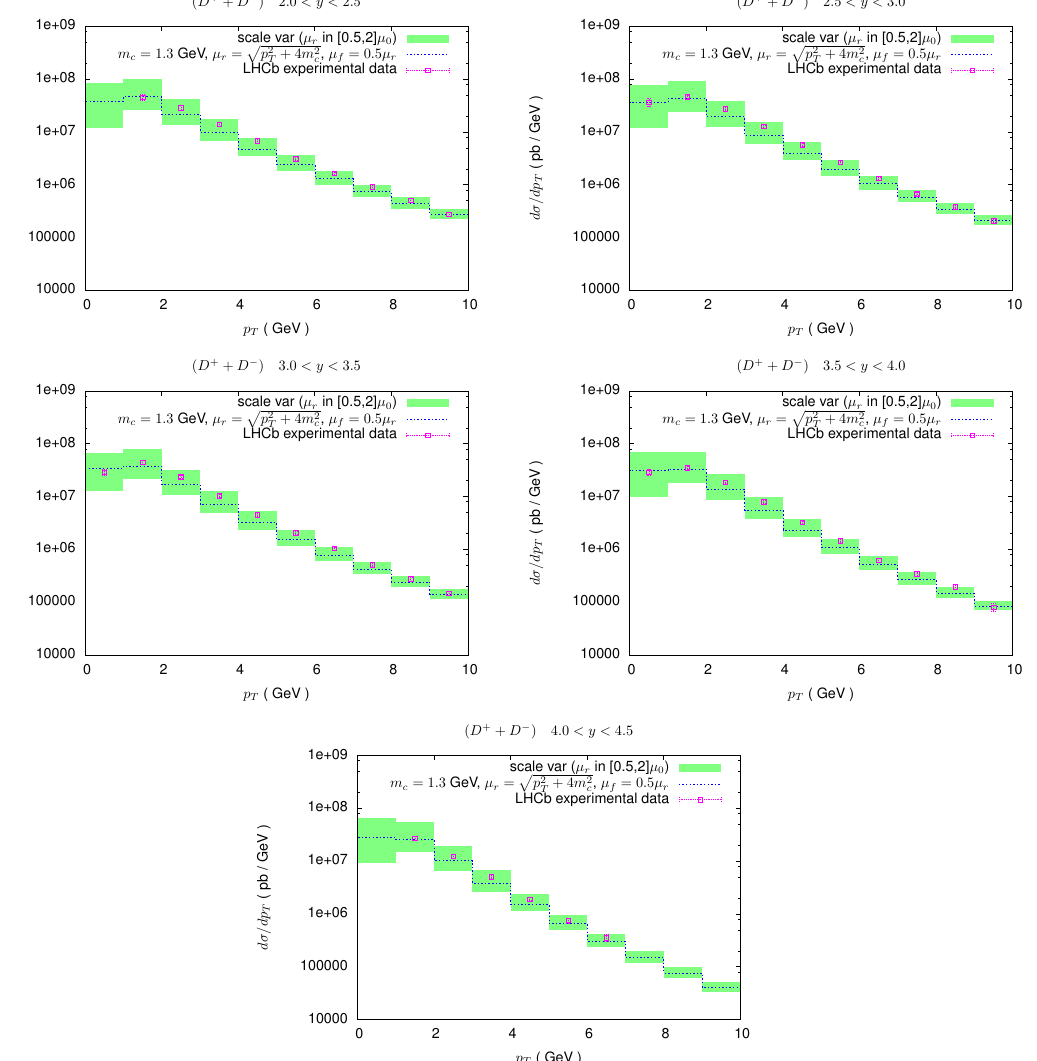
Figure 2 . Our GM-VFNS predictions for ( D + + D (cid:0) ) transverse-momentum distributions for pp collisions at p S = 5 TeV vs. LHCb experimental data of ref. [43]. Each panel corresponds to a di(cid:11)erent rapidity bin in the interval 2 < y < 4.5. The renormalization scale (cid:22) r is chosen as p 2 + 4 m 2 , and varied in the [0.5, 2] interval around this central value, whereas the factorization c T scales (cid:22) i and (cid:22) f are (cid:12)xed at (cid:24) p 2 + 4 m 2 , with (cid:24) i;f = 0 : i=f c T p p